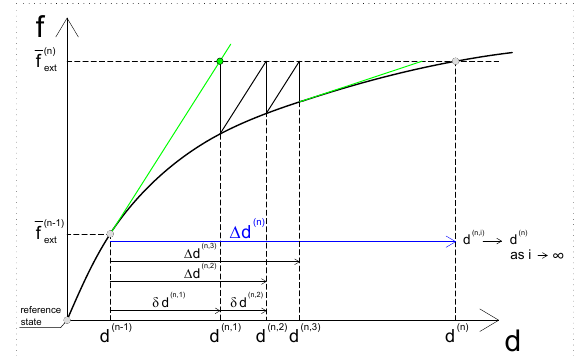
Figure 3. Modified Newton - Raphson method.